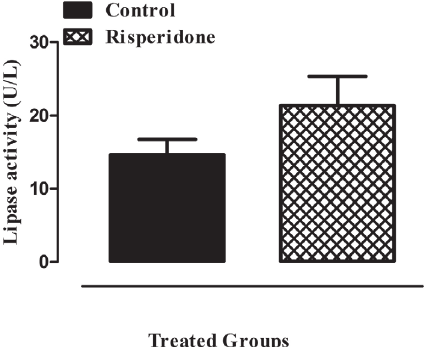
FIGURE 4 - Effect of Risperidone (2.5 mg/kg/d) on lipase: Three weeks oral treatment of rats exhibited no significant increase in lipase level (U/L) in risperidone treated group as compared to control (not significant) (unpaired t-test).